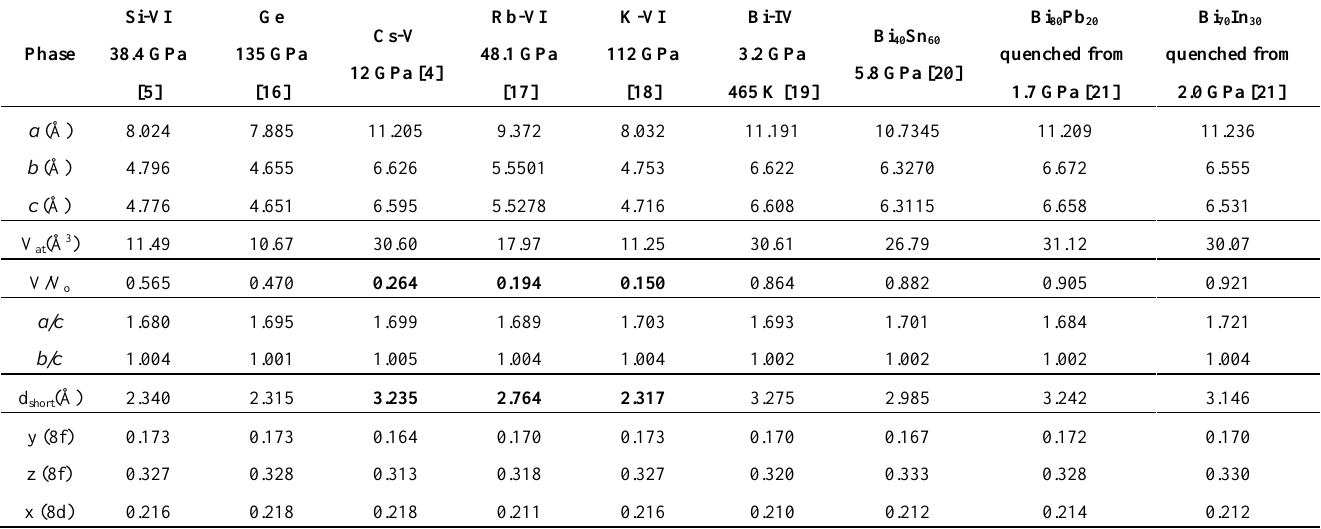
Table 2. Structural details of all the known Cmca-oC 16 phases, formed under pressure in the pure elements Cs, Rb, Si, Ge, and Bi, and in Bi-alloys with In, Sn, and Pb (experimental data are taken from references indicated for each